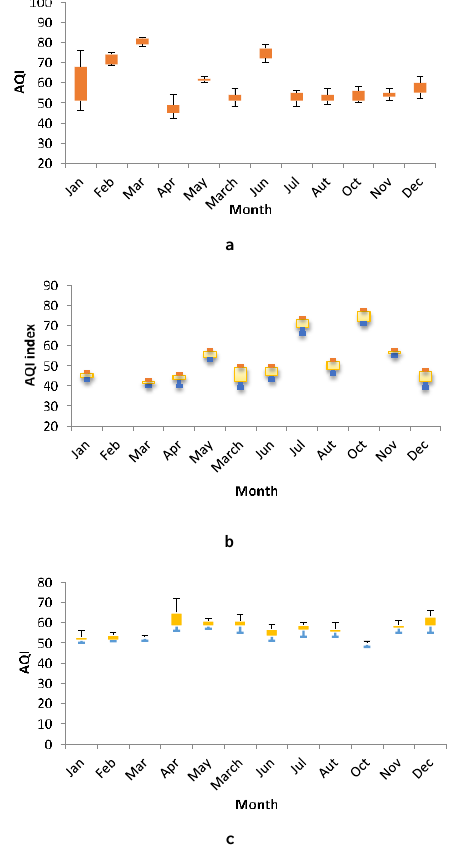
Figure 2. AQI for ( a ) East Azarbayjan, ( b ) Ardebil, and ( c ) Gilan.